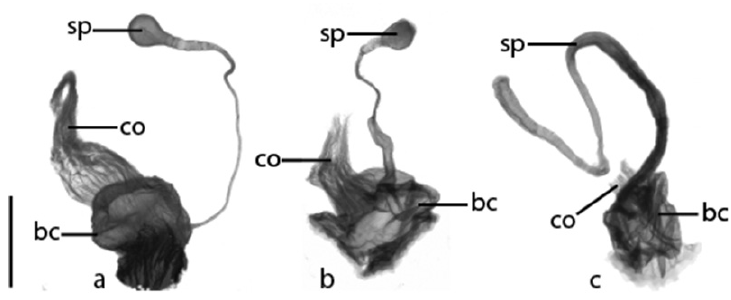
Figure 12. Ventral view of anterior portion of female reproductive tract. a Cratocerus sinesetosus b Cra- tocerus culpepperi and c Cratocerus kavanaughi . Abbreviations: bc, bursa copulatrix; co, common oviduct; sp, spermatheca. Scale bar = 0.25